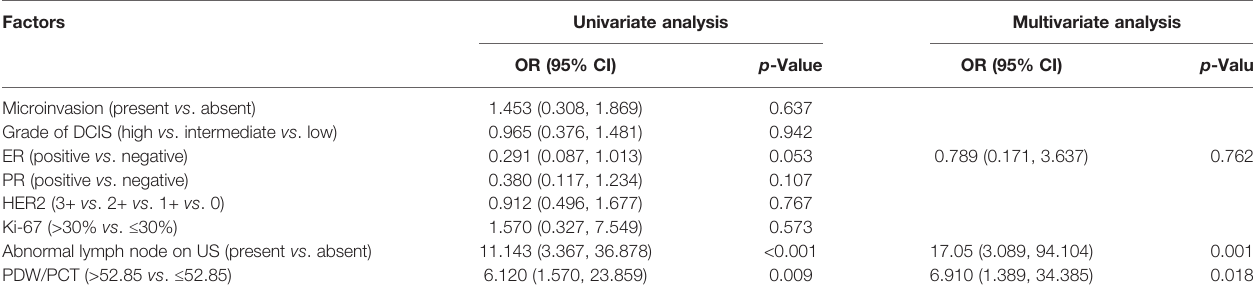
TABLE 4 | Risk predictors for axillary lymph node metastasis.